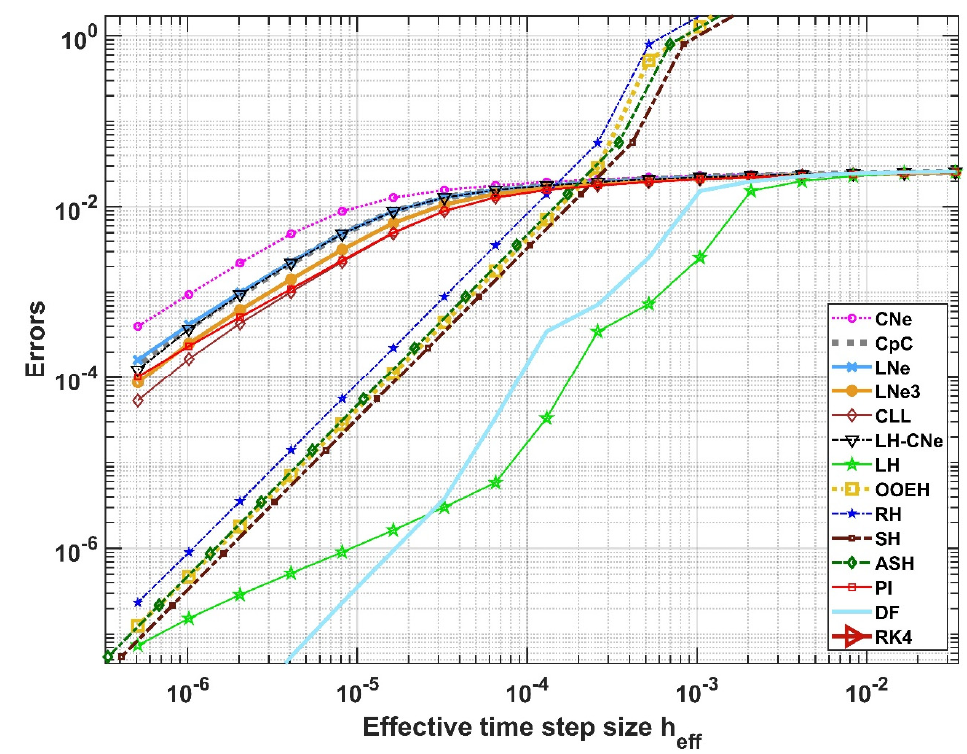
Figure 8. The L ∞ errors as a function of the time step size h for an equidistant mesh for large x (Experiment 2). RK4 is not present in the figure because it is unstable for the examined time step sizes, as the CFL limit for the standard RK4 method is approximately h ≈ 1.2 · 10 − 7